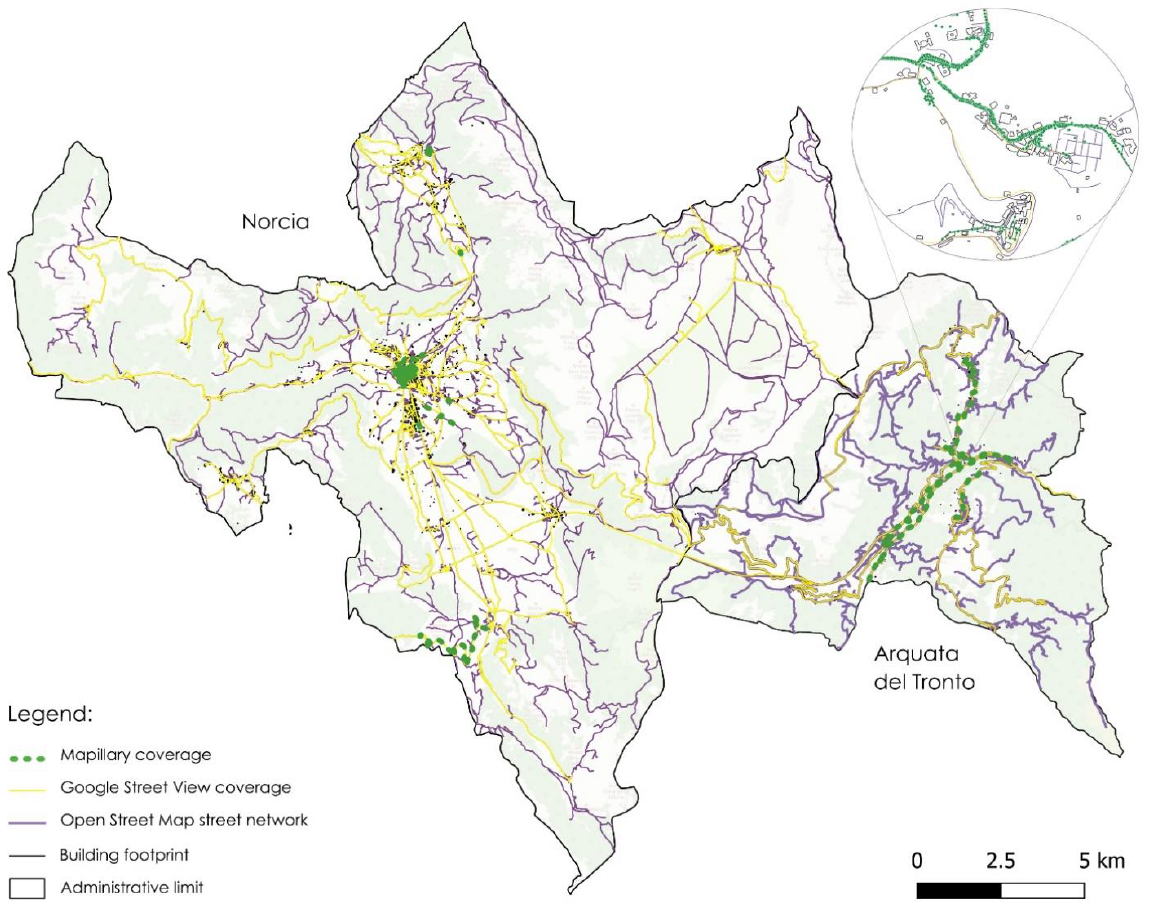
Figure 2. GSV, OSM and Mapillary coverage (in the zoom a dot represents a single pictures) of Norcia and Arquata del Tronto, Italy